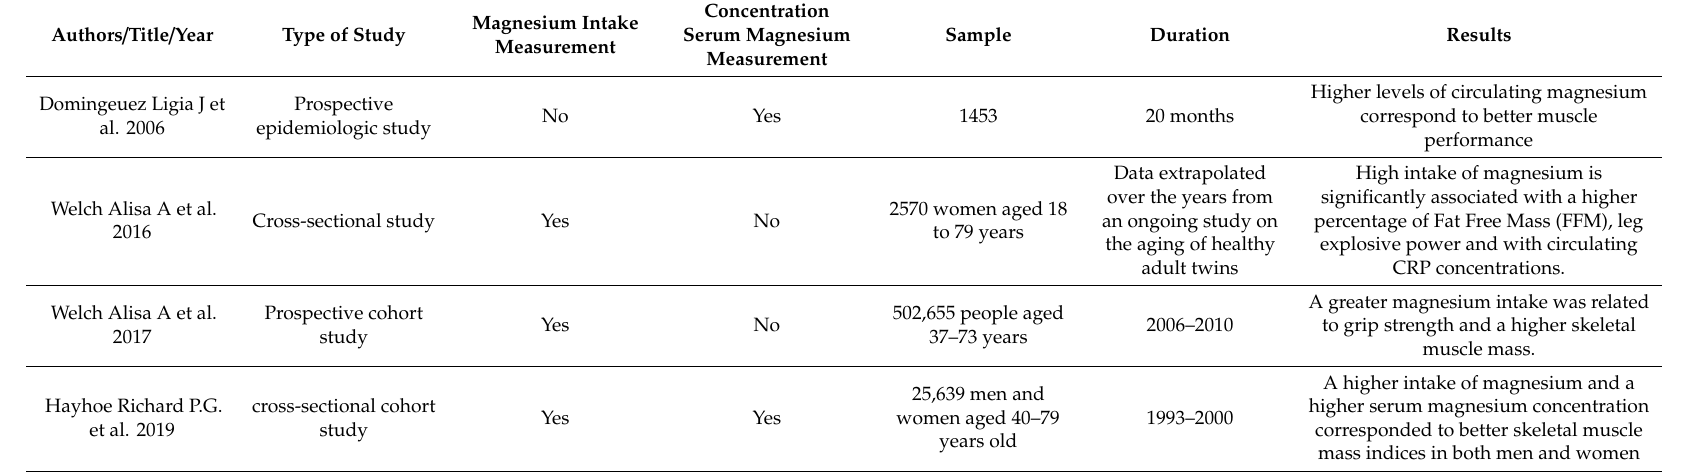
Table 4. Summary of studies on magnesium considered in this narrative